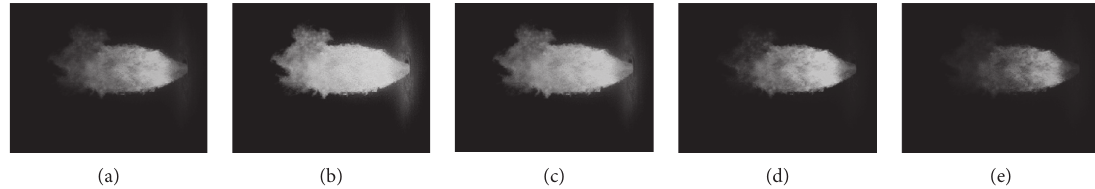
Figure 3: The comparison results of flame image II under different methods: (a) average method; (b) maximum method; (c) weighted average method 1; (d) weighted average method 2; (e) weighted average method